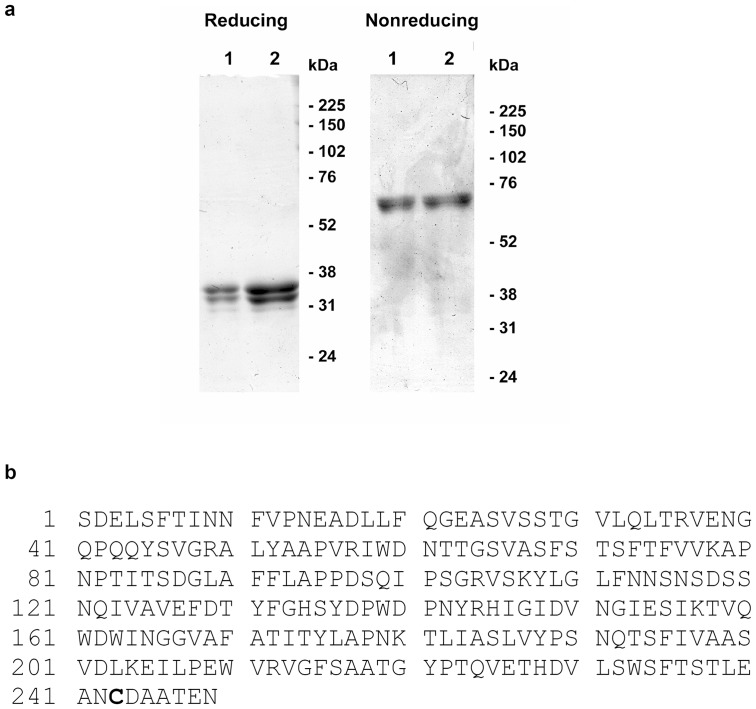
Analysis of MASL protein subunits.(a) MASL from Sigma (lane 1) or Sentrimed (lane 2) was analyzed by reducing and nonreducing SDS-PAGE. (b) Coomassie stained bands were excised, extracted and digested with trypsin, reduced and alkylated with iodoacetamide, and sequenced using data dependent acquisition by LC-MS/MS on a Thermo Scientific LTQ Orbitrap XL. All peptides were identical in primary sequence and contained a single cysteine at residue 243 (bold in figure).